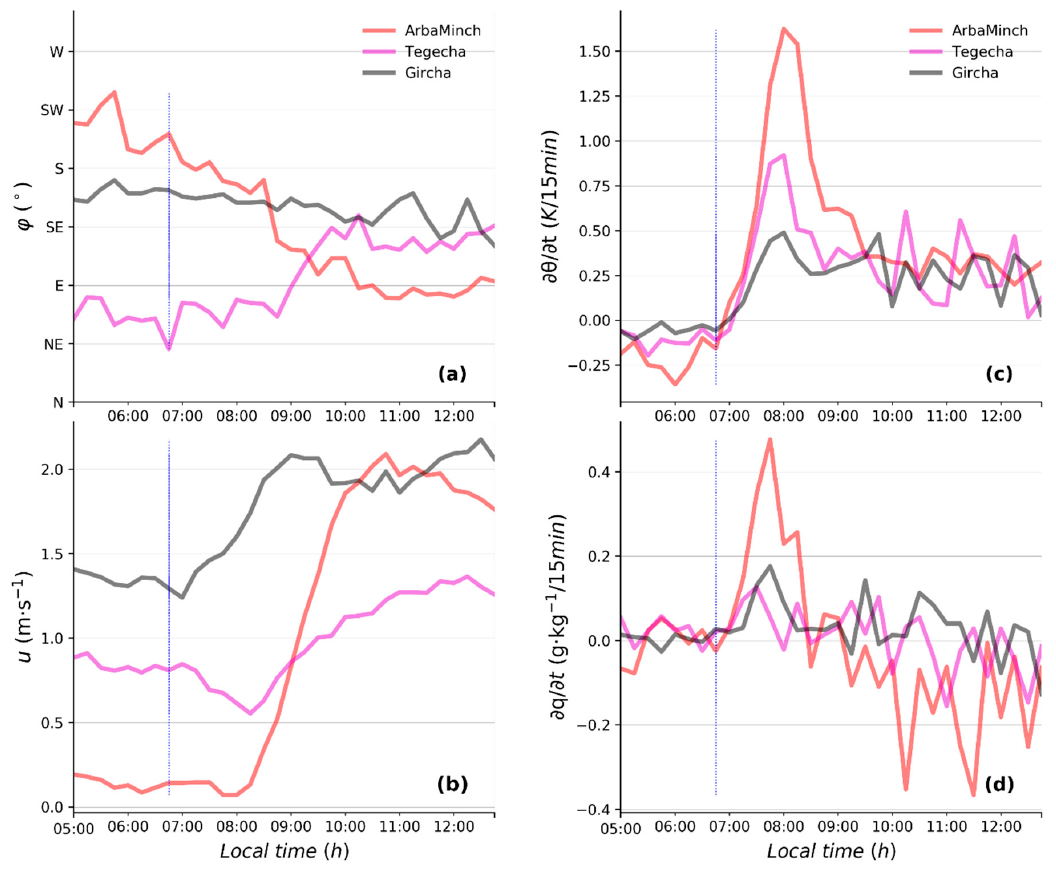
Figure 7. ( a ) ϕ ( ◦ ), ( b ) u (m · s − 1 ), ( c ) ∂ θ / ∂ t (K/15-min), and ( d ) ∂ q/ ∂ t (g · kg − 1 /15-min) during the shift from stratified boundary layer to convective boundary layer in February 2017. The vertical lines show the approximate time of sunrise time in February 2017.